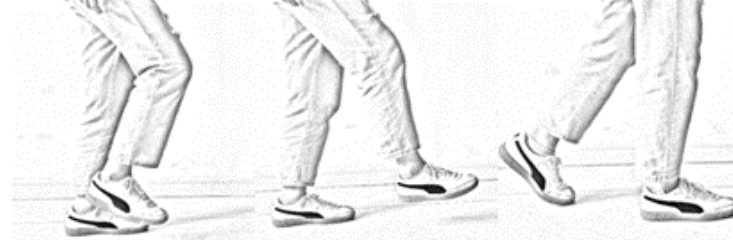
Figure 4. Single step action decomposition.